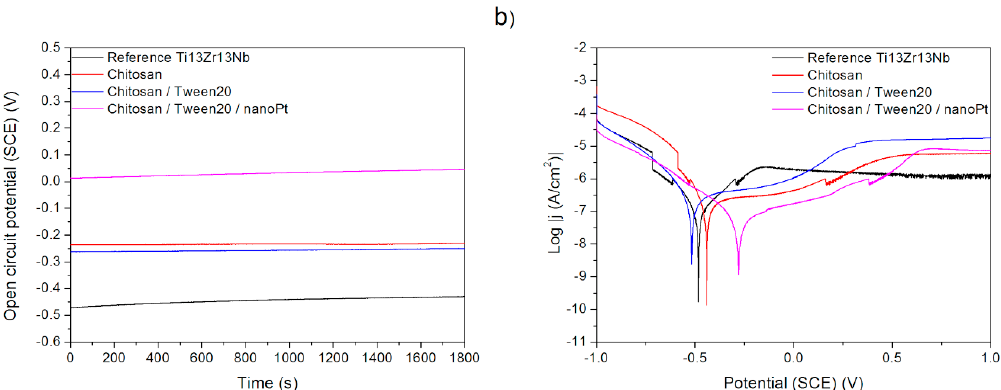
Figure 10. ( a ) Open-circuit potential vs. time and ( b ) potentiodynamic corrosion curves obtained for Ti13Nb13Zr substrate after its surface modifications: Reference—ground, Chitosan—ground and coated with chitosan, Chitosan/Tween 20—ground and coated with chitosan and Tween 20 solution, Chitosan/Tween 20/nanoPt—ground and coated with chitosan/Tween 20 + nanoPt solution .